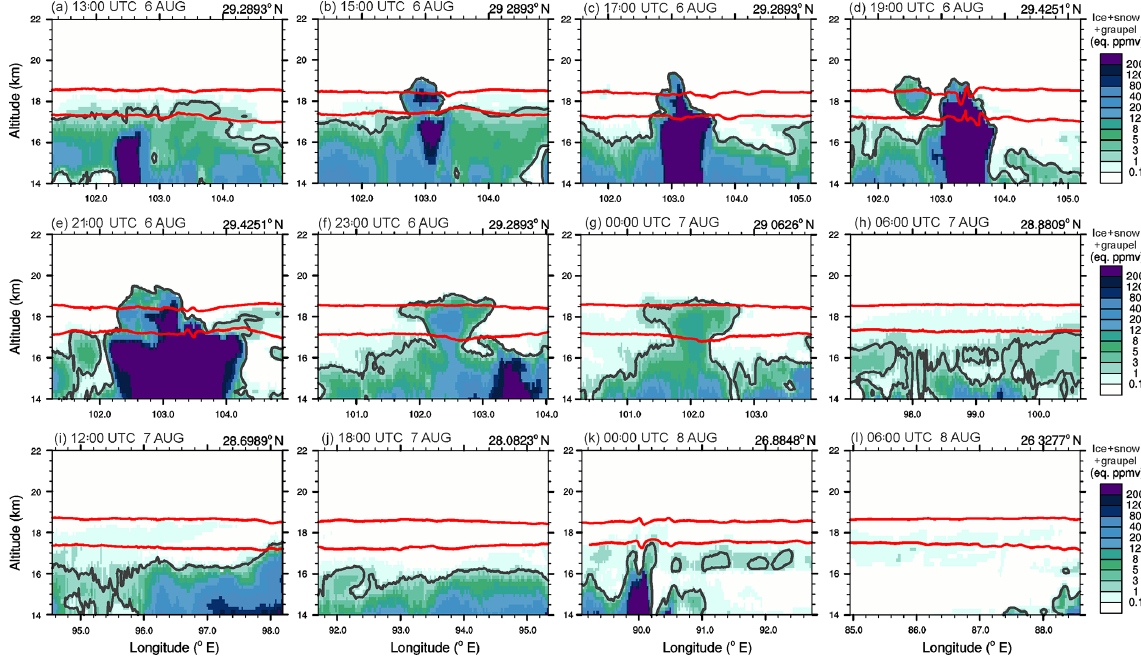
Figure 7. Same as Fig. 6 but for the ice content. The isentropic altitudes of 380 and 410K are depicted by the red lines.